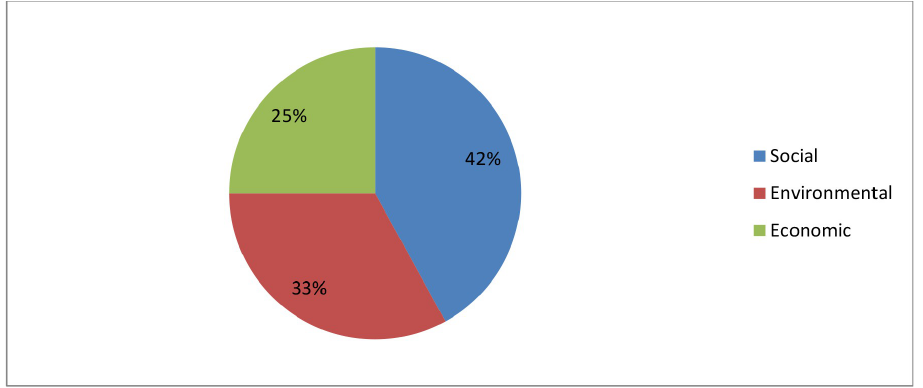
Figure 2. Degree of importance of sustainability criteria in the case